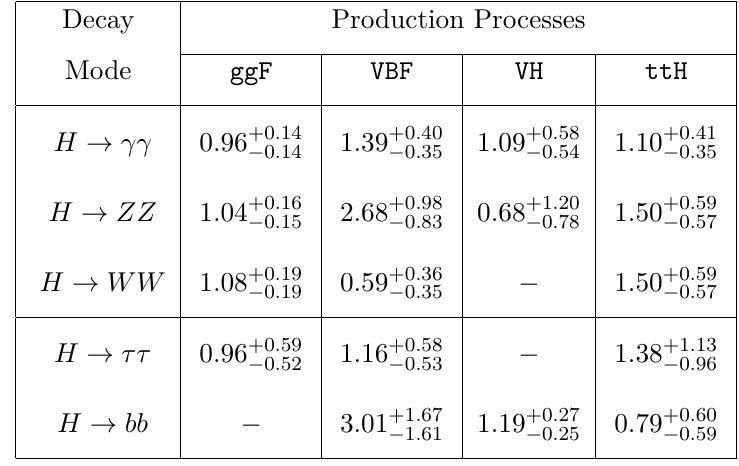
Table 2 . ATLAS results for 13 TeV data, taken from ref. [25].